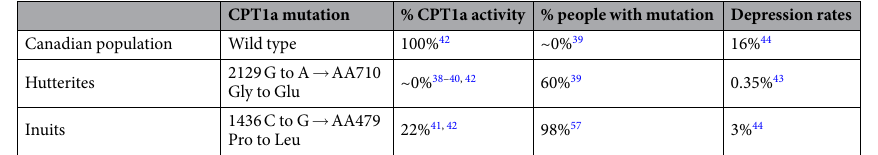
Table 2. Carnitine palmitoyl transferase 1a (CPT1a) mutations in humane